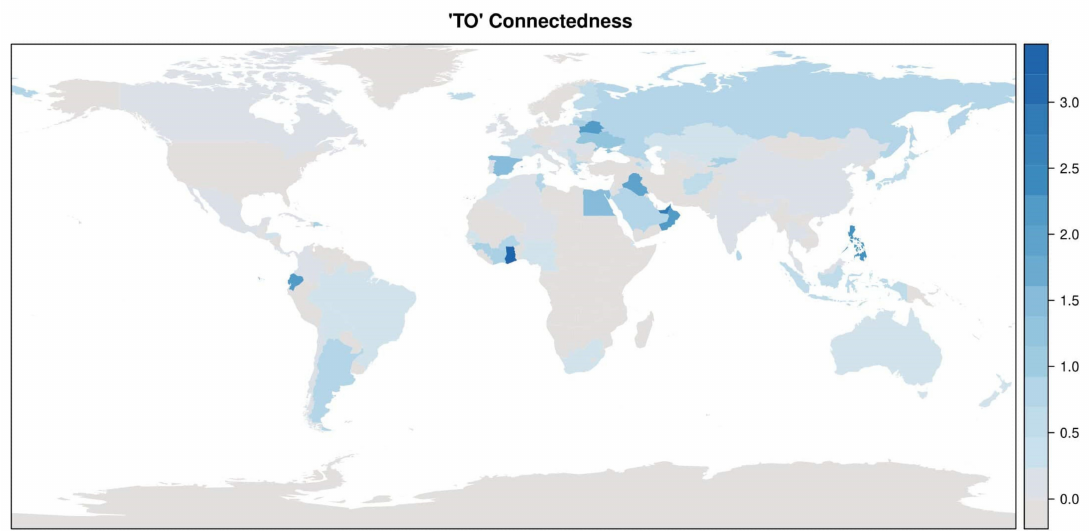
Figure 5. Directional “TO” connectedness measure, or